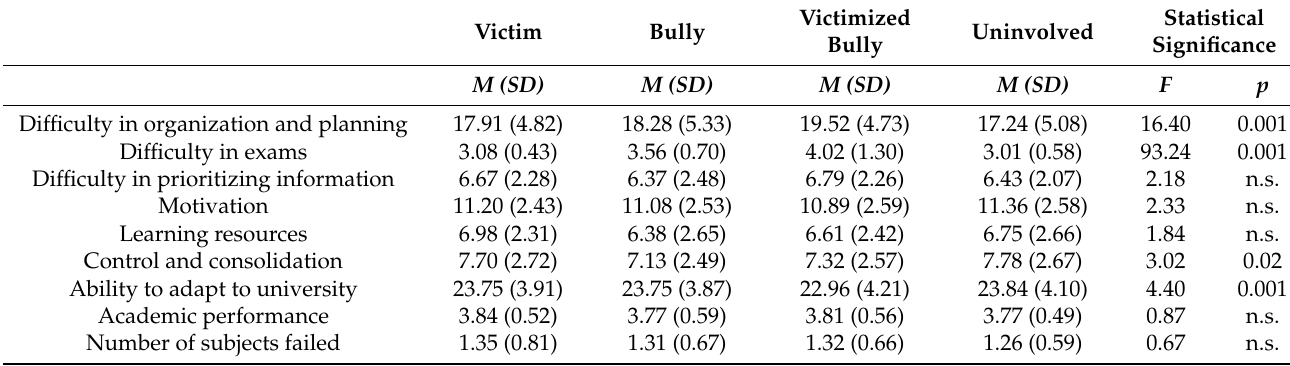
Table 1. Differences in means and standard deviations of personality traits and aggressiveness between victims and pure bullies, victimized bullies, and uninvolved